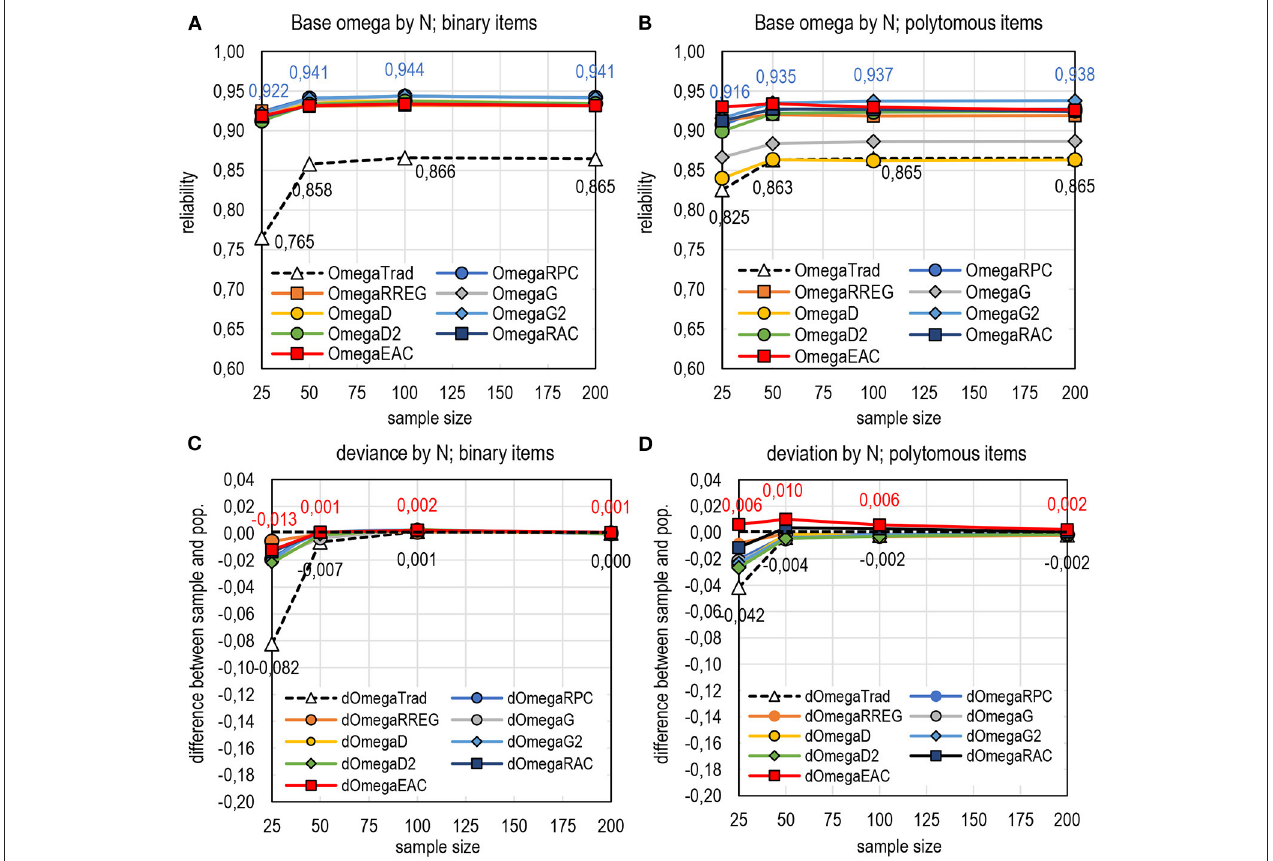
FIGURE 9 | The behavior of DCERs based on omega by sample size. (A) Base omega by N; binary items. (B) Base omega by N; polytomous items. (C) Deviance by N; binary items. (D) Deviation by N; polytomous items.